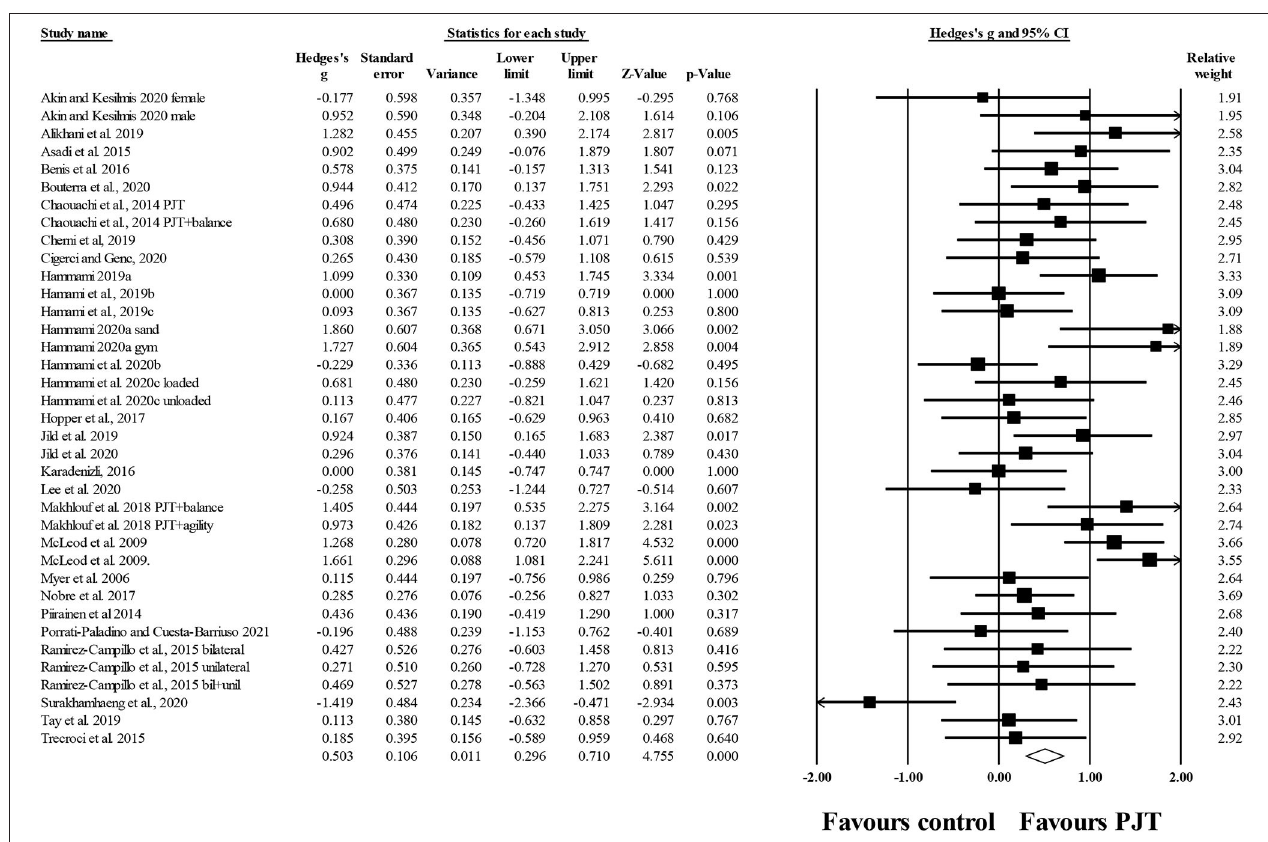
FIGURE 3 | Forest plot of changes in overall dynamic balance (i.e., all dynamic tests included) in participants that completed a plyometric jump training (PJT) program compared to participants allocated as controls. Values shown are effect sizes (Hedges’s g) with 95% confidence intervals (CI). The size of the plotted squares reflects the statistical weight of each study. The diamond reflects the overall